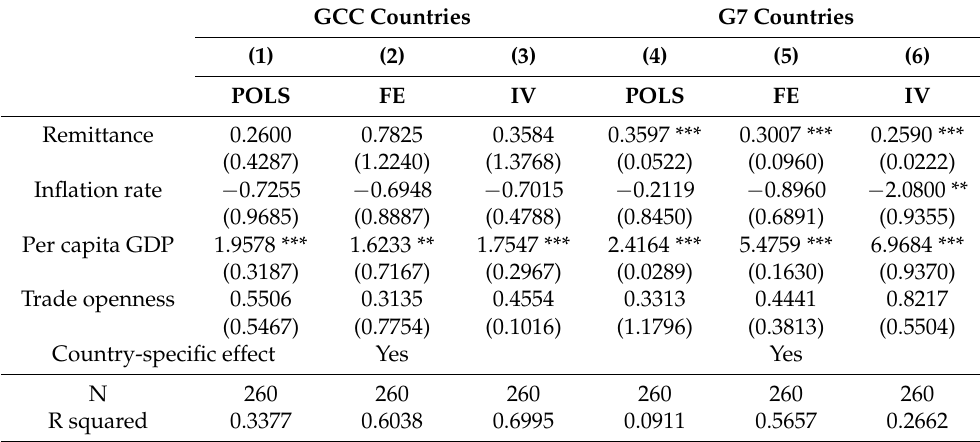
Table 6. Impacts of remittance on stock market capitalization.